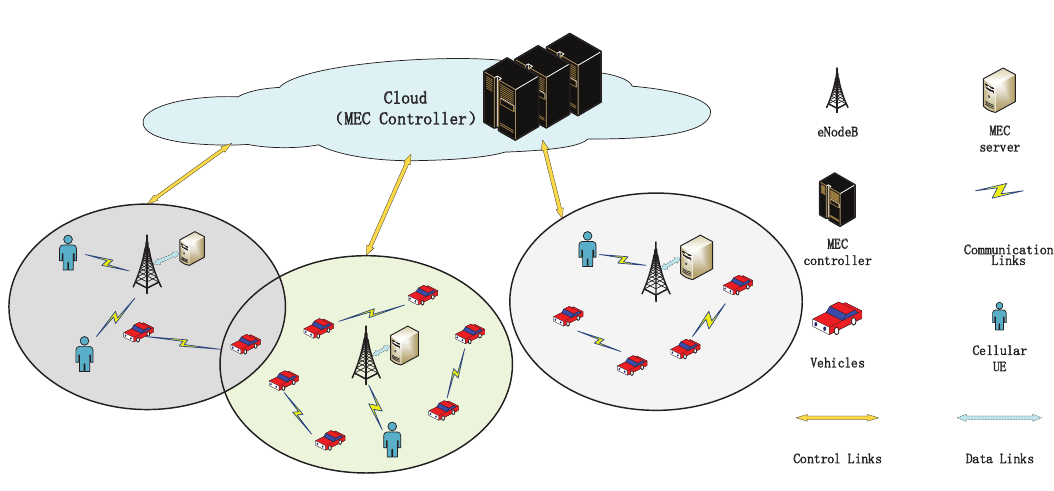
Figure 1. System model of the multi-cell scenario with multiple mobile edge computing (MEC)